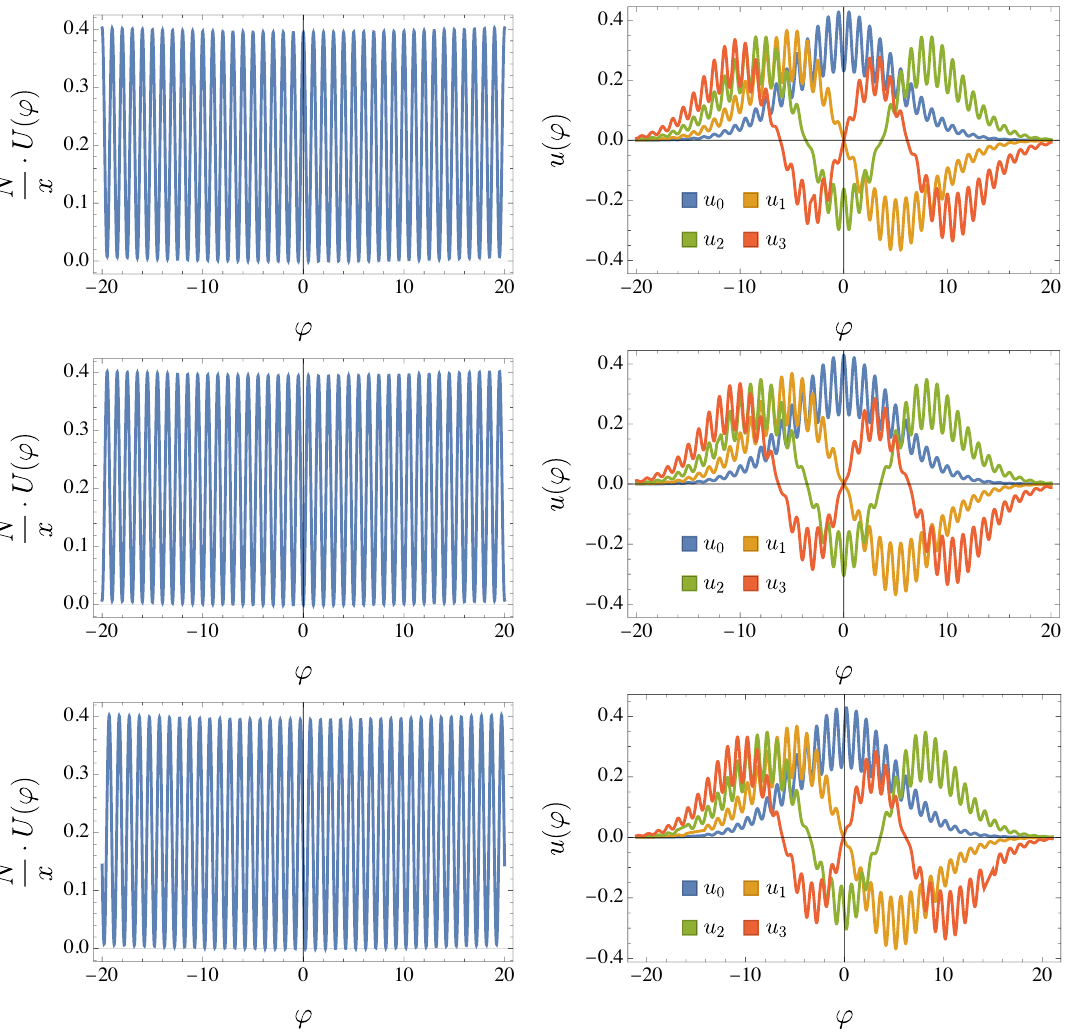
Figure 10. The (dimensionless) effective quantum mechanical potential in (4.6) and the (dimen- sionless) wavefunctions of the lowest two Hamiltonian eigenstates for m/g = 50 , mL = 1 , a nearly SHO regime example, on N = 10 lattice. Upper panel: α = 0 . 5 , middle panel: α = 0 , lower panel: α = 0 . 2 . The wavefunctions u 0 , u 1 , u 2 and u 3 are respectively the ones in ϕ -representation for the ground, the first-, the second- and the third-excited